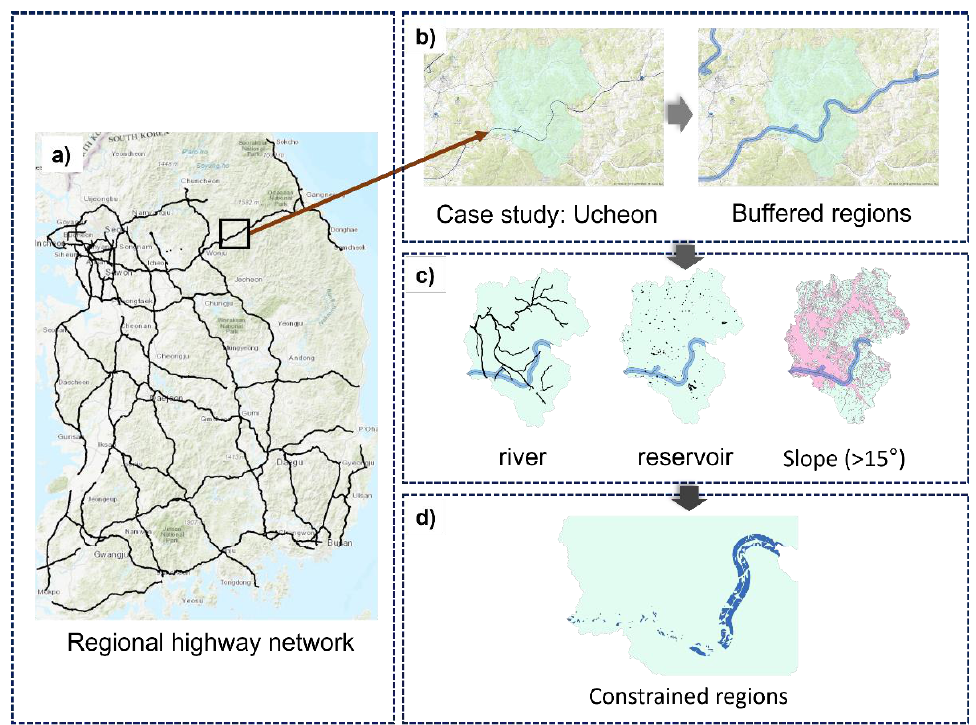
Figure 3. Computational geo-spatial analysis process for selecting sites near highway networks; ( a ) existing national highway in South Korea, ( b ) restriction conditions of the distance to highway networks (< 200 m), ( c ) restriction conditions of non-installable areas (e.g., river, reservoir, higher slope), and ( d ) the result of constrained regions by spatial analysis in the case area.